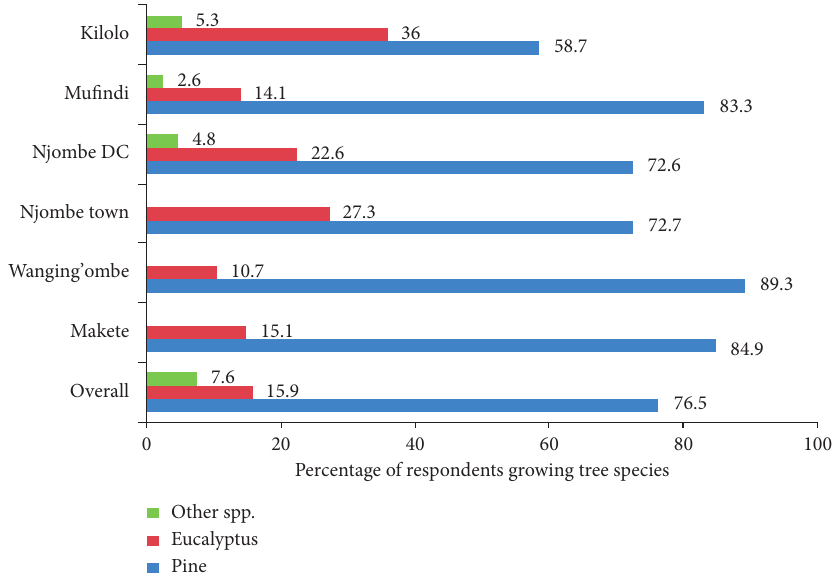
Figure 2: Tree species grown in the study districts (source: own field data).